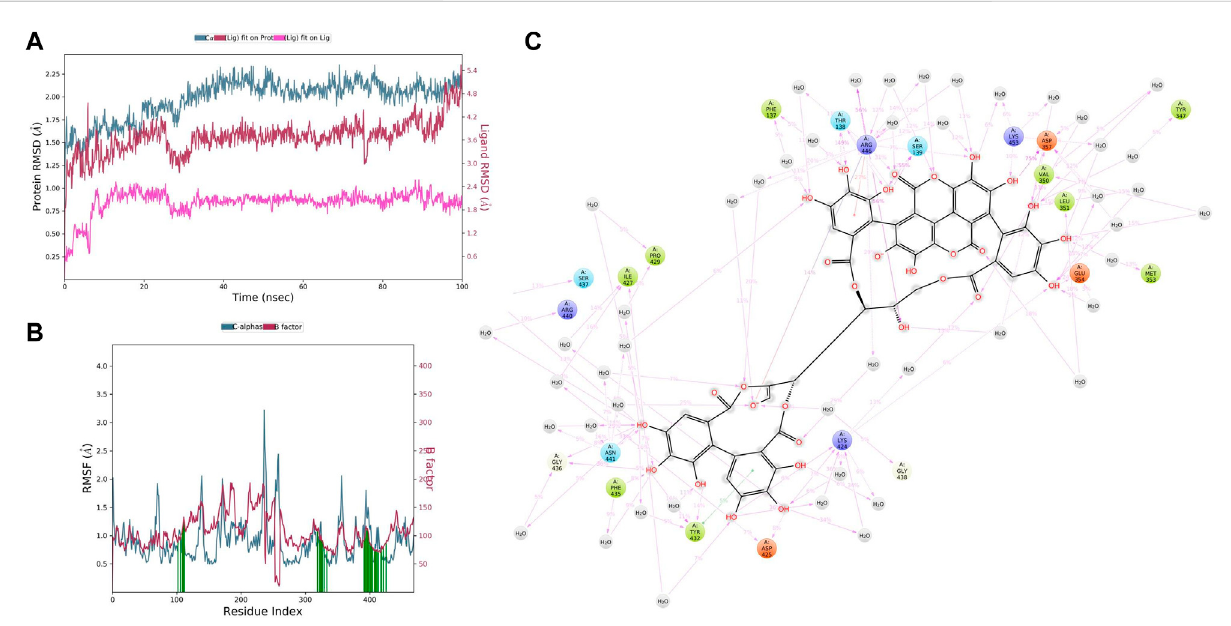
FIGURE 8 (A) RMSD of CYP3A4 and punicalagin after the initial RMSD values were stabilized. This plot shows RMSD values for CYP3A4 on the left Y -axis, whereas for punicalagin, these values are indicated on the right Y -axis. The RMSD graph for the c-alpha is shown in blue color, the graph for ligand fi t on ligand isshown inpink color, and thegraph for punicalagin fi t on CYP3A4 isshown inred color. (B) RMSFof CYP3A4 backboneand punicalagin complex; red color shows the B factor, meaning the PDB, and green color means the interaction of punicalagin with the CYP3A4 with timescale. (C) CYP3A4 – punicalagin interaction during the molecular dynamics